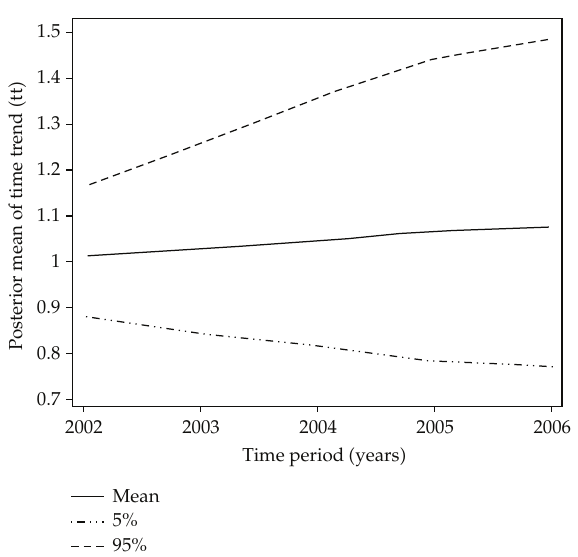
Figure 3: Time series plot for posterior mean estimates of the time trend with 95%